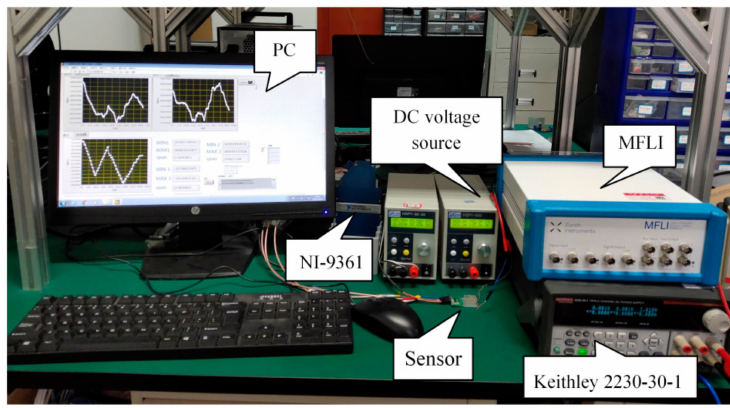
Figure 6. The overall view of the experimental setup.